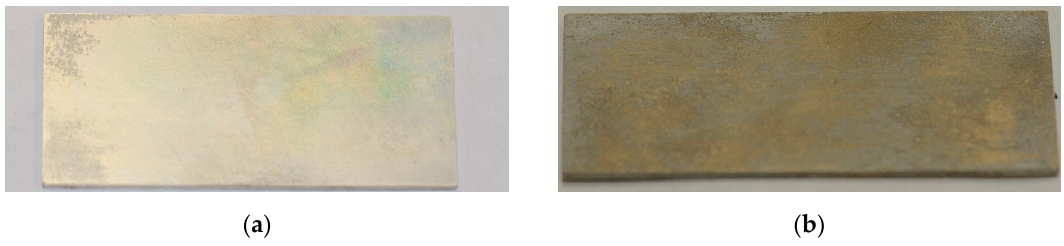
Figure 4. Macro morphology of WE43-T5 ( a ) before the 1st day and ( b ) after the 7th day.